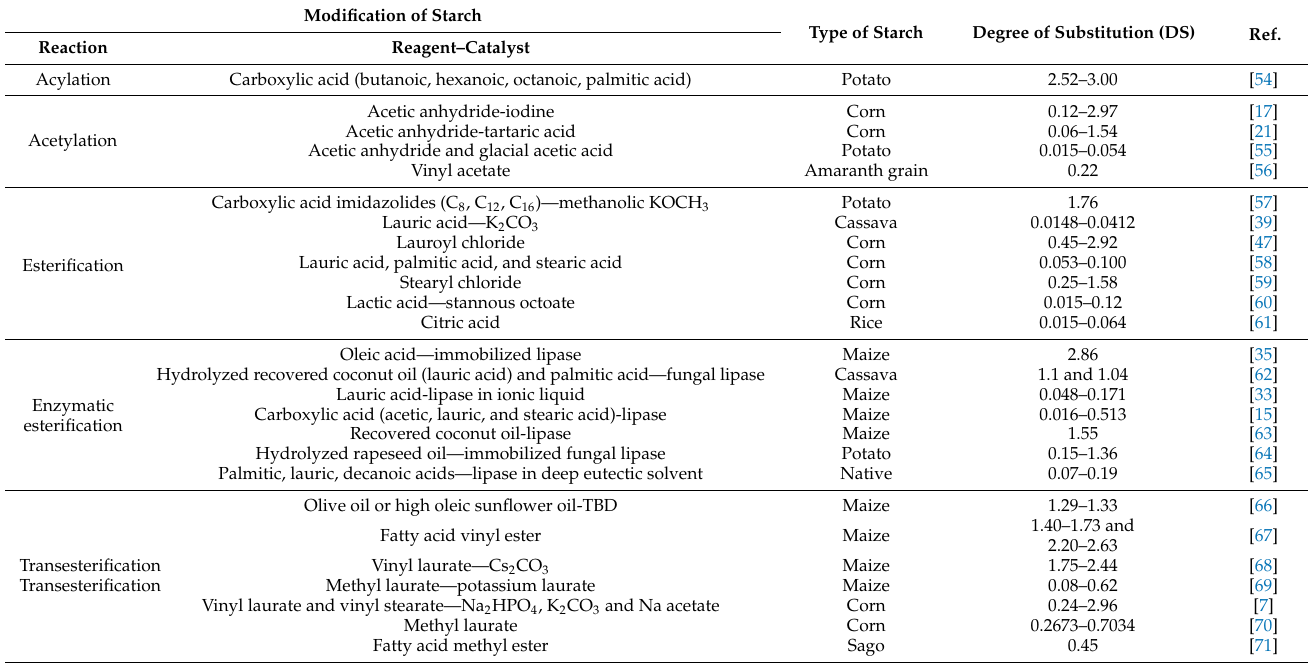
Table 2. Reactions affording starch esters and their degree of